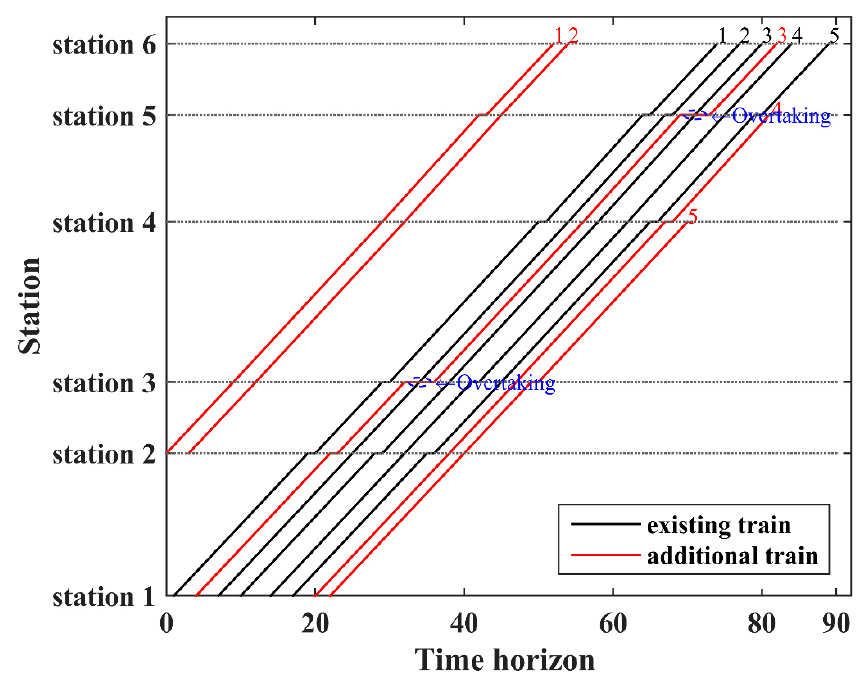
Figure 6. Timetables for existing trains and additional train.